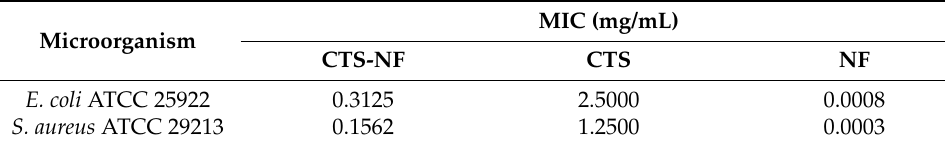
Table 4. In vitro antimicrobial activity of CTS-NF.